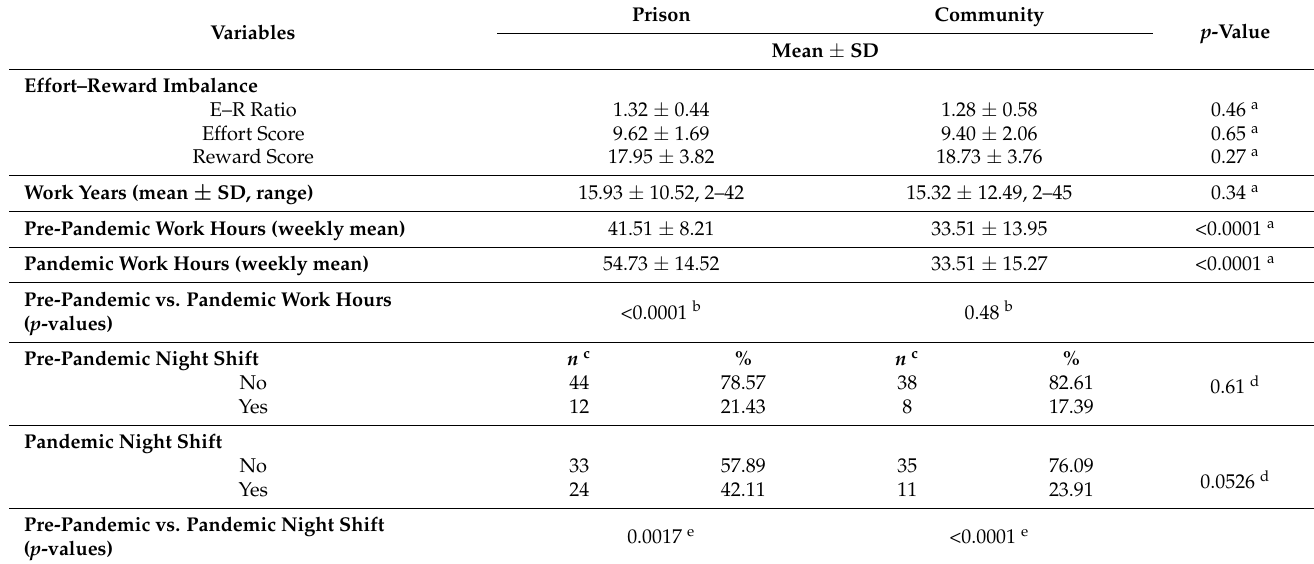
Table 2. Psychosocial and organizational work characteristics.